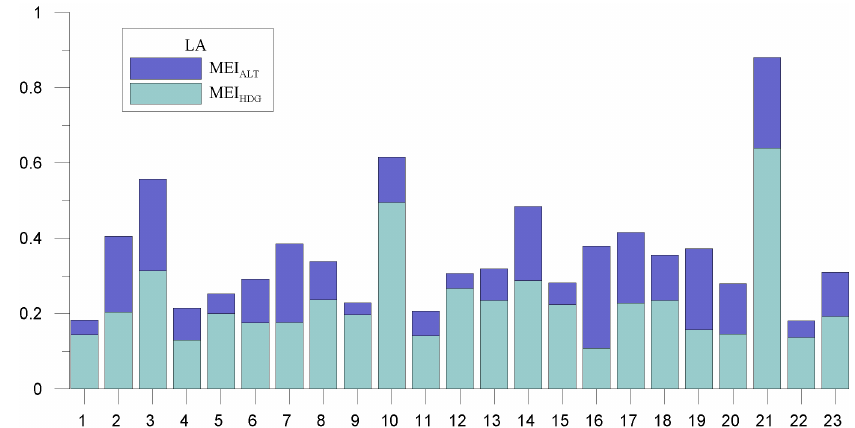
Figure 8. Maneuver Error Index for LA segment.